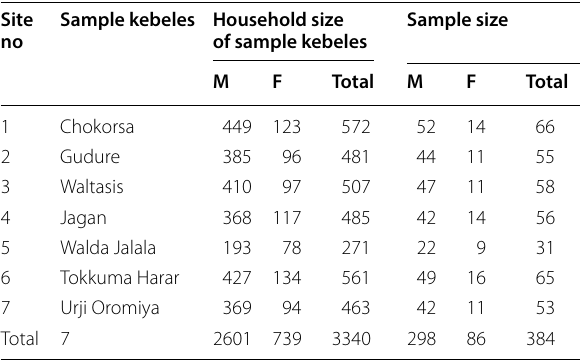
Table 2 Distribution of total and sample households in the sample kebeles. Source: field survey (2018) Site Sample kebeles Household size no of sample